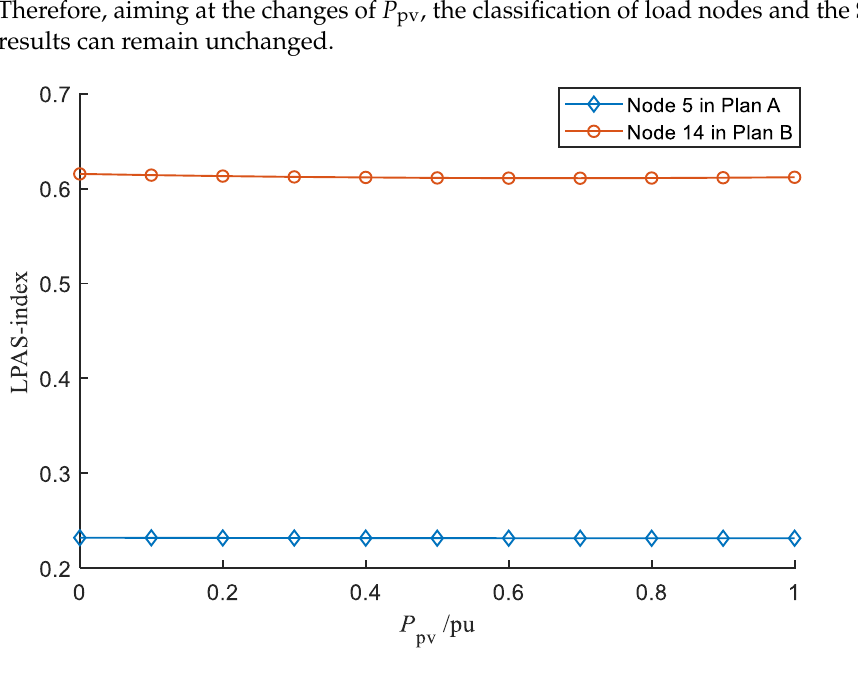
Table 3. The values of L-index and LPAS-index of load nodes under Plan C (Load multiple lm = 1 pu).